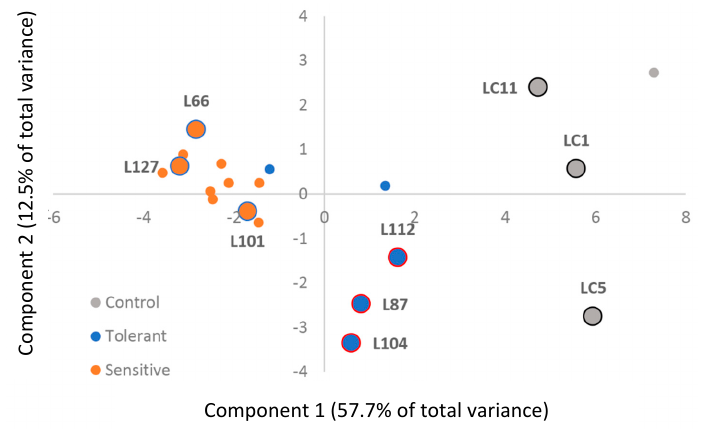
Figure 3. Table 2. Physiological and nutritional phenotype of the plants between groups after 0, 30, 45, and 60 days. Different letters represent significant differences ( p < 0.05) between groups.